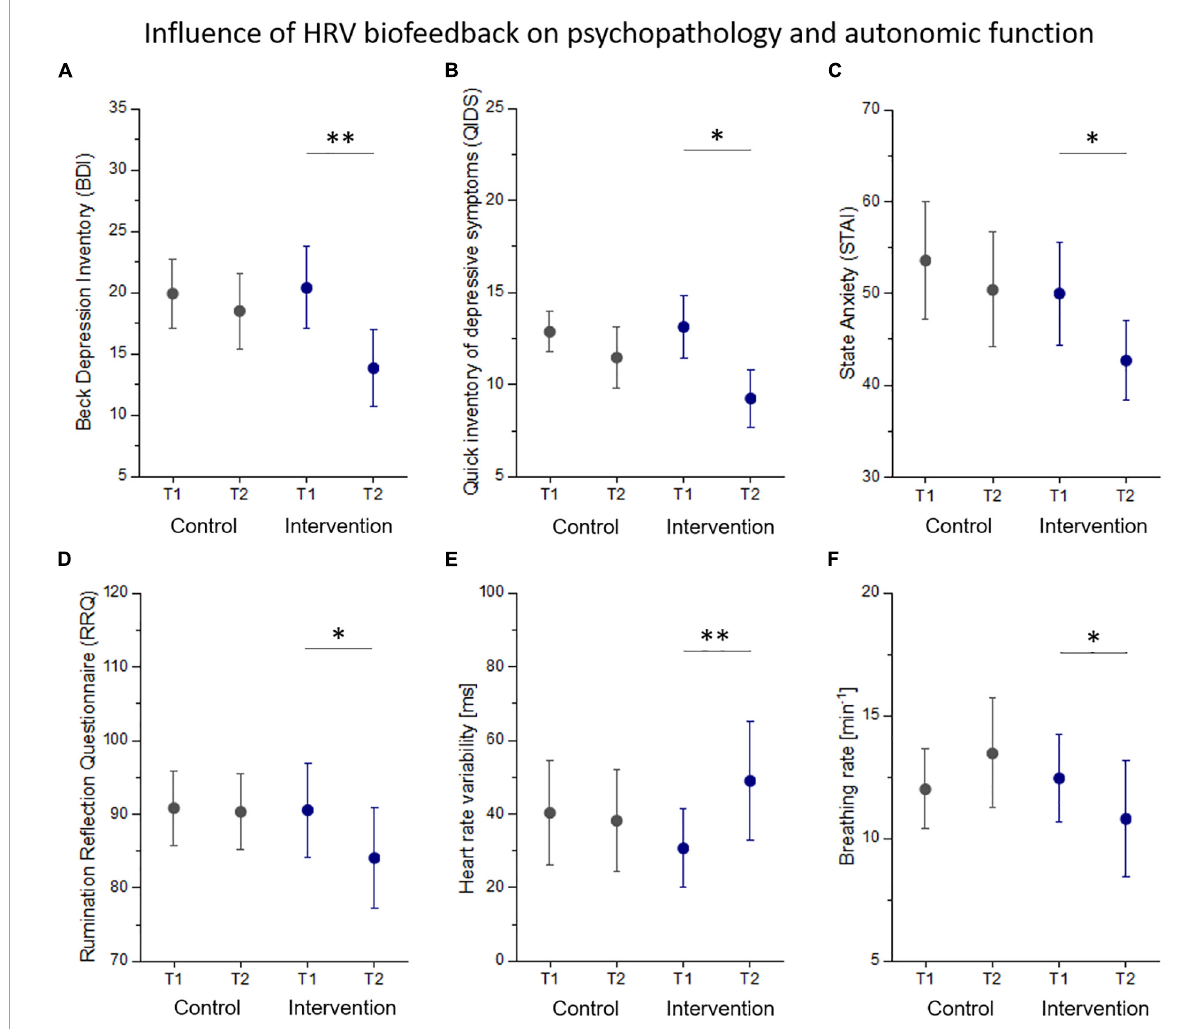
FIGURE2 Changes in psychopathology (A–D) and autonomic function (E,F) from before (T1) to after (T2) the control and intervention condition. Statistical thresholds: ∗ p < 0.05, ∗∗ p < 0.01.